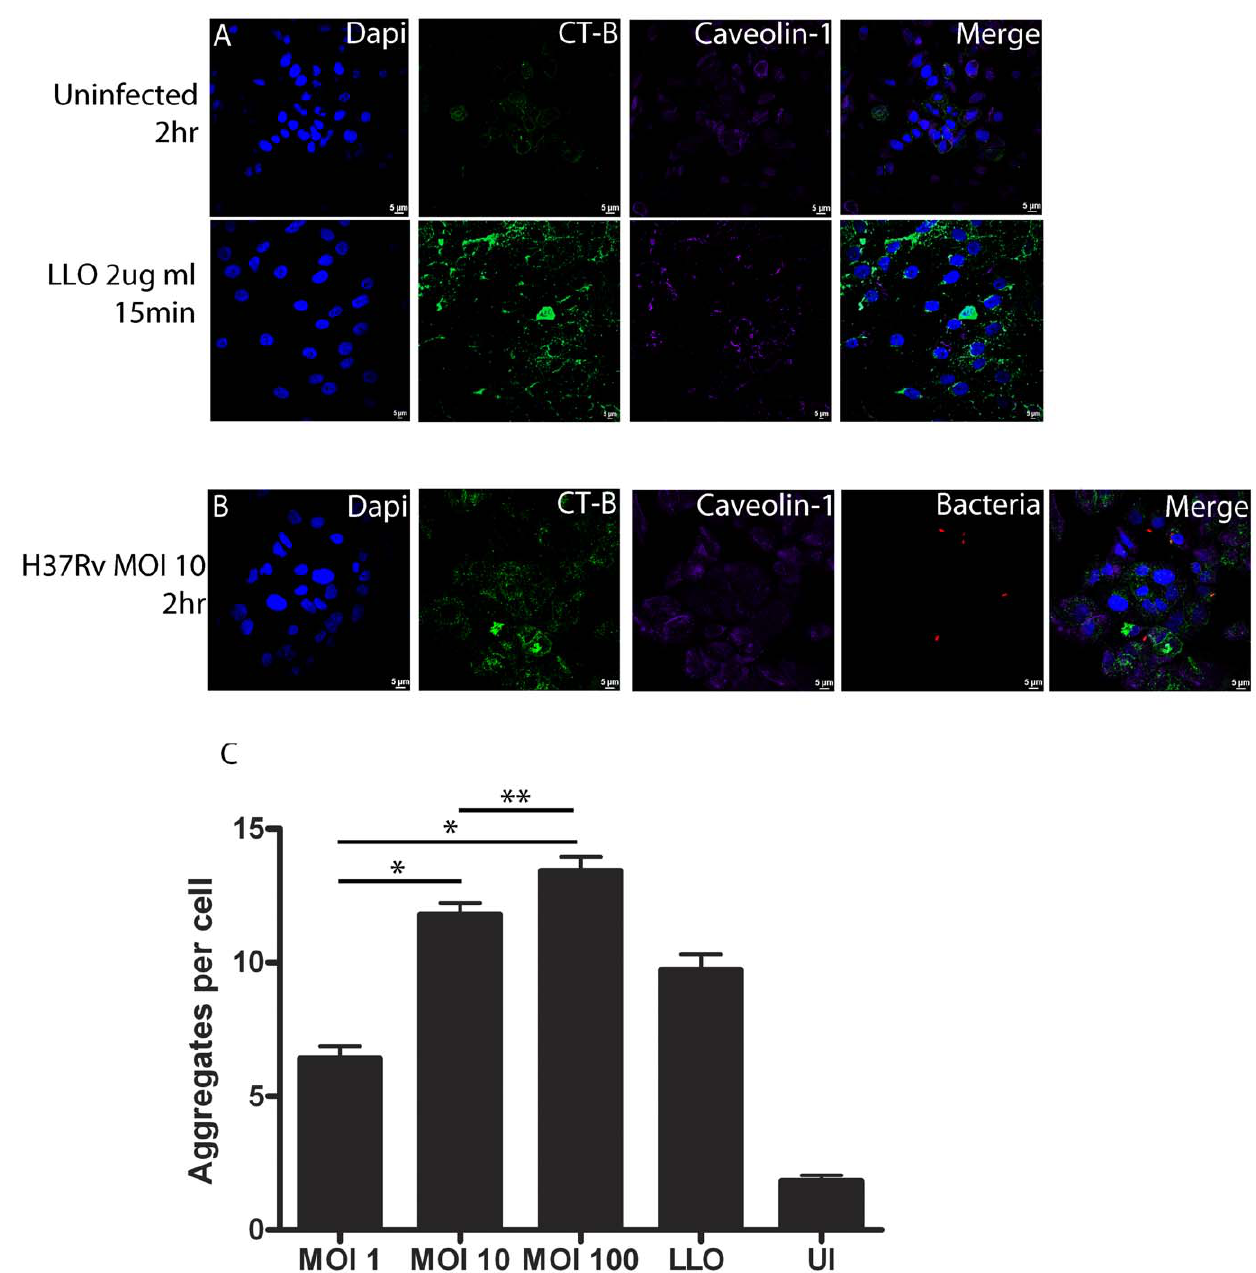
Figure 1. Mtb bacilli induce LR aggregation at 2 hr post infection. A549 type II alveolar epithelial cells were infected with Mtb strain H37Rv at three bacterial multiplicities of infection (MOI) and analyzed at 2 hr post infection (hpi) by confocal microscopy as described. Uninfected and Listeriolysin-O (LLO) treated cells were also analyzed as negative and positive controls for lipid raft (LR) aggregation, respectively. Images demonstrate that infection with H37Rv (MOI 10) produced an increase in the number of LR aggregates compared to uninfected controls (A–B). Quantification of LR aggregates produced for MOI 1, 10 and 100 demonstrate LR aggregation comparable to LLO positive controls (p-value . 0.05) (C). Significantly more LR aggregates per cell (APC) were detected from H37Rv infected cells compared to uninfected controls (p-value , 0.001). A dose-dependent increase in LR aggregation was also noted among H37Rv infections MOI 1 ( , 6 APC), MOI 10 ( , 12 APC), and MOI 100 ( , 14 APC) ( * p- value , 0.001; ** p-value , 0.05). Infections were performed in duplicate and experiments repeated three times. A total of 15 fields were imaged per coverslip, incorporating approximately 30–50 host cells per field. Images were captured at 63x magnification and LR aggregation assessed using ImageJ software. Results represent the average of three